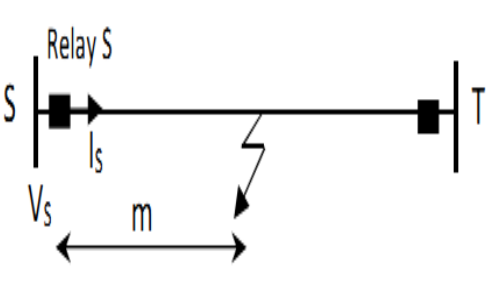
Fig. 2: Fault in transmission line Saida-Tiaret.